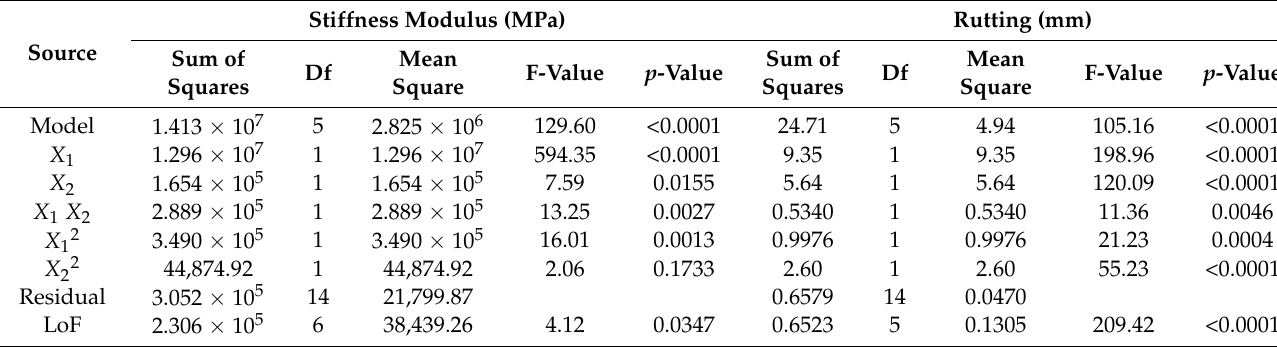
Table 5. ANOVA results for